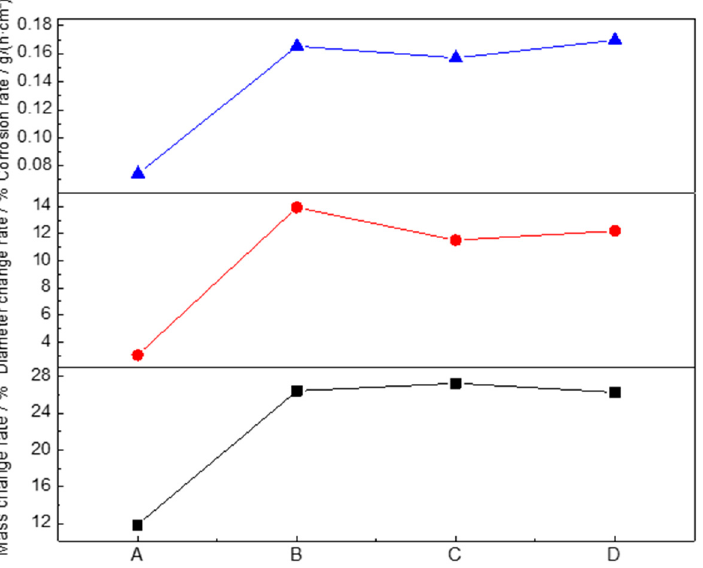
Figure 5. Mass change rate, diameter change rate, and corrosion rate of the four carbon bricks after corrosion (A, B, C and D are the types of carbon bricks).